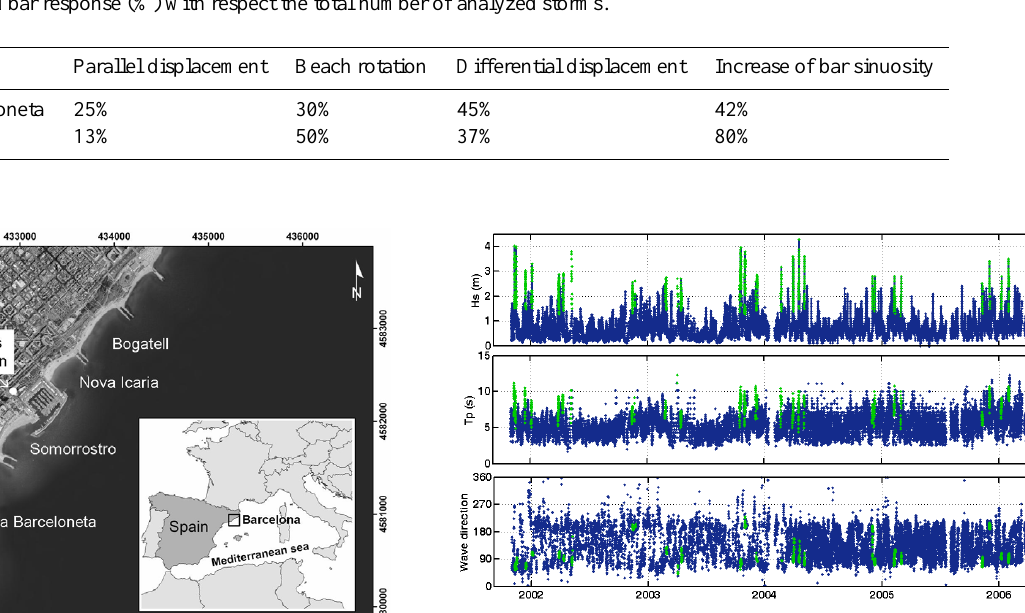
Figure 3. Bogatell (left) and La Barceloneta (right) planviews on November 3 rd , 2003. The coloured line indicates the shoreline location before the southern storm event, on October 30 th , 2003, showing beach rotation at the Bogatell beach and the formation of megacusp and shoreline retreat at La Barceloneta beach.